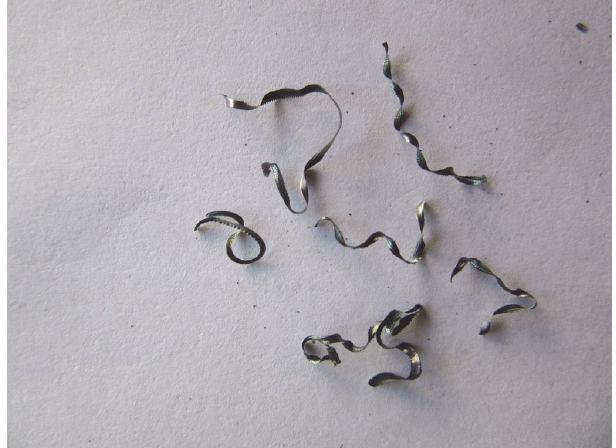
Fig. 3. Image of chips at Run 7 (v = 190 m/min, f = 0.12 mm/rev and d = 0.2